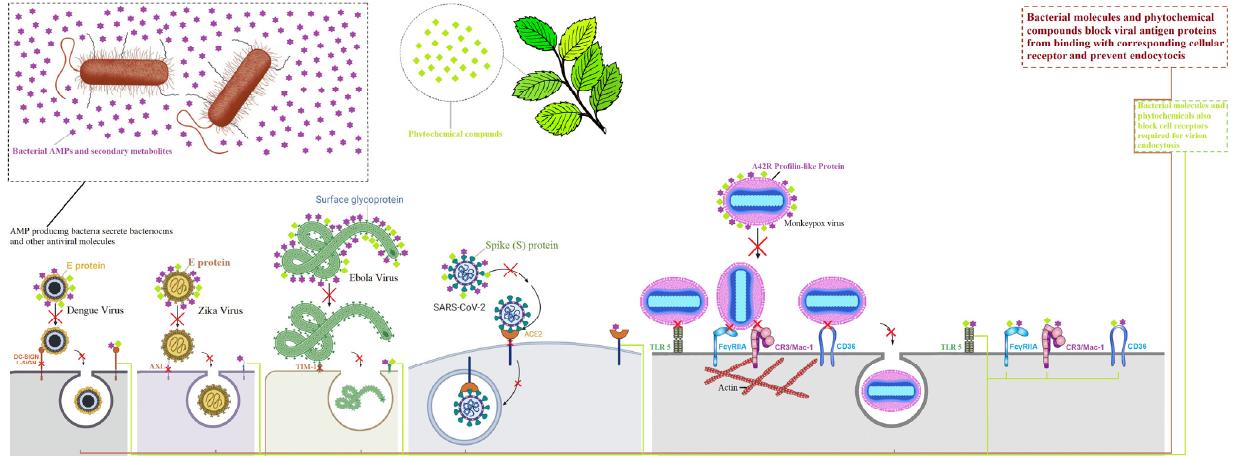
Figure 7. Proposed antiviral mechanism of action of bacterial molecules and phytochemicals against DENV, EBOV, ZIKV, MPV, and SARS-CoV-2, by targeting the interaction between viral surface proteins and cell receptors (DC-SIGN, AXL, TIM-1, ACE2, Toll-like receptor 5, Fc γ RIIA, CR3/Mac- 1 and CD36). Phytochemicals are incapable of binding with AXL and ACE2 cell receptors and lyngbyabellin A is unable to bind with the surface E protein of DENV. These natural biomolecules may contribute to reducing viral pathogenesis in host